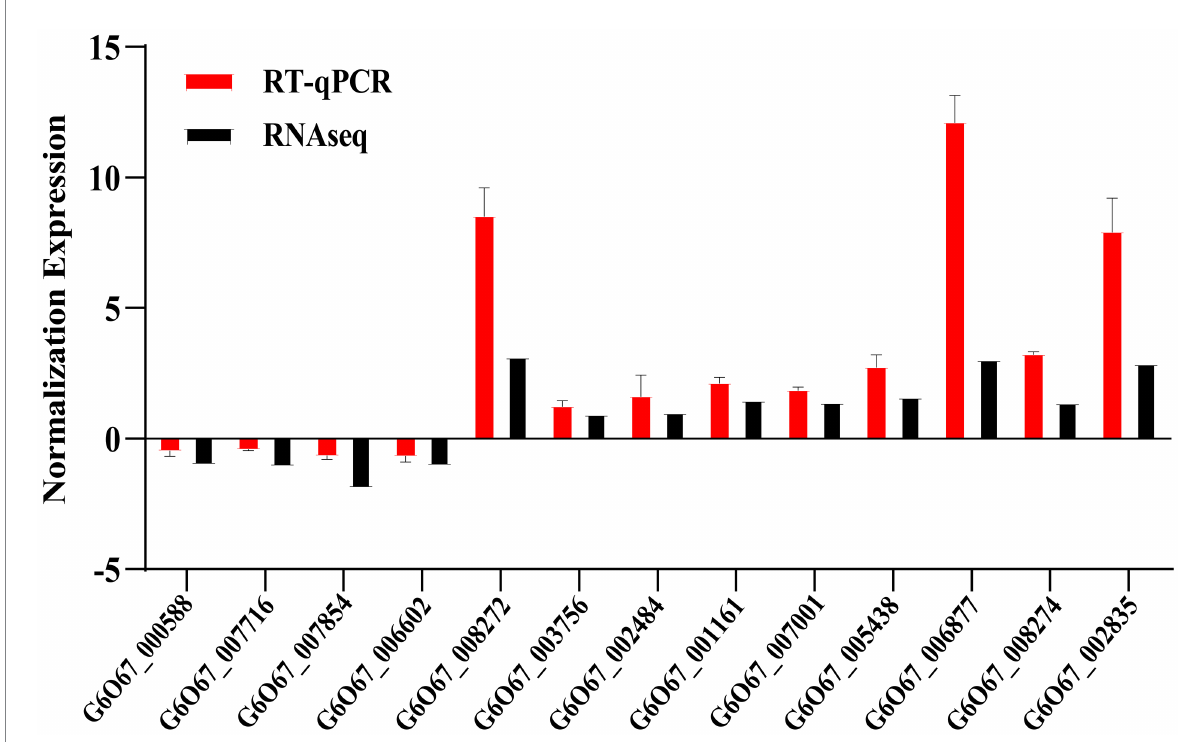
FIGURE 5 Quantitative identification of differentially expressed genes. Red bars represent RT-qPCR results (2 − ΔΔ Ct ). Black bars indicate RNA-seq results (log2 fold change). Error bars represent standard errors. ACT1 gene was the internal